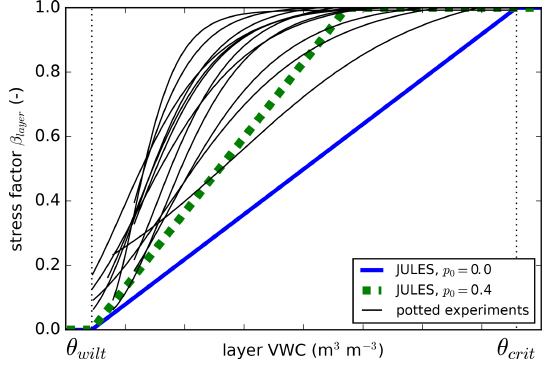
Figure 1. Comparison of JULES soil moisture stress factor ( β ) to measurements from various potted experiments from Verhoef and Egea (2014). β is calculated from Eq. (4). Two different values of p0 (Eq. 5) are shown: p0 = 0.4 was used for the “soil14_p0” and “p0” soil moisture stress